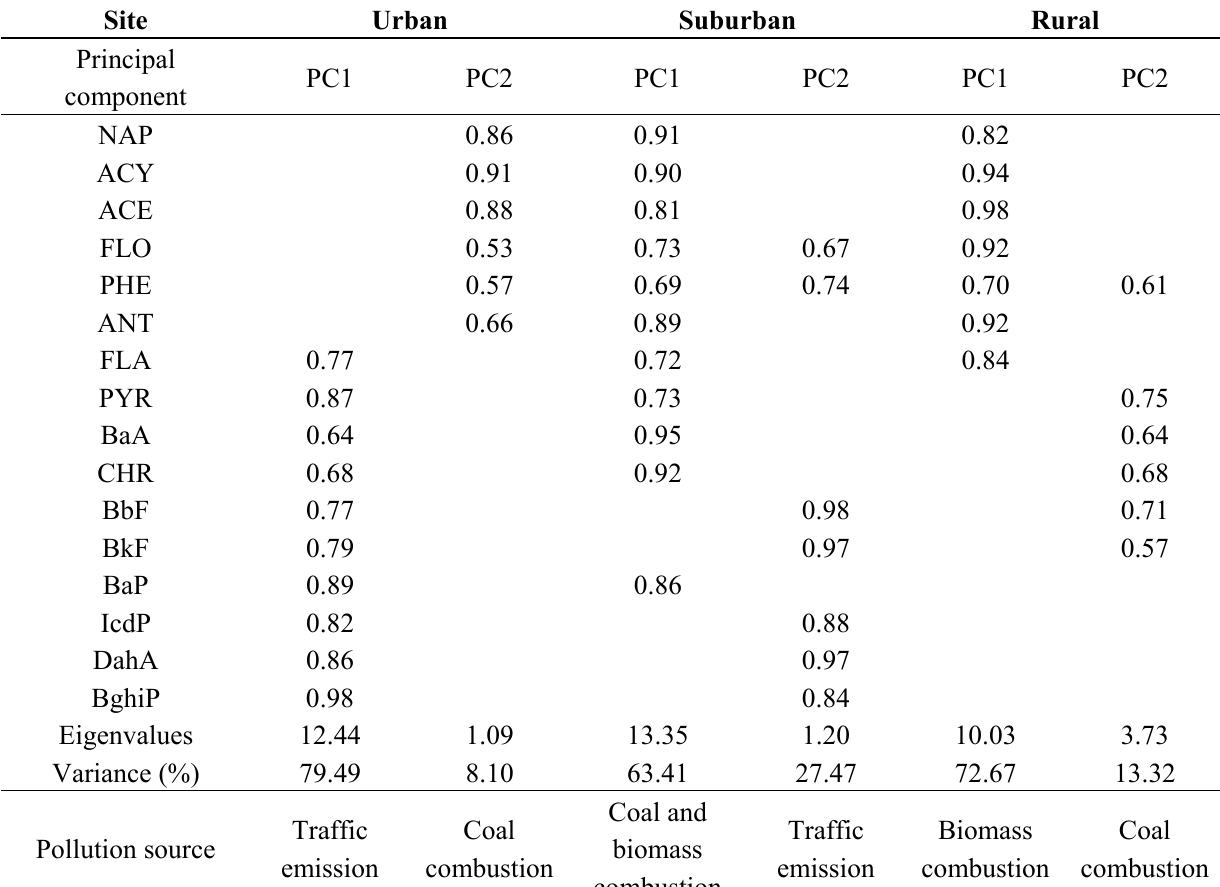
Table 2. Principal component analysis after Varimax rotation for the selected PAHs in forest soils in urban, suburban, and rural sites. Only factors with loading values greater than 0.5 were